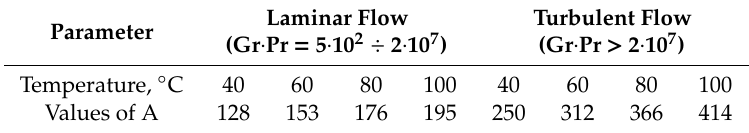
Table 1. Values of A constant for water excluding the e ff ect of radiation